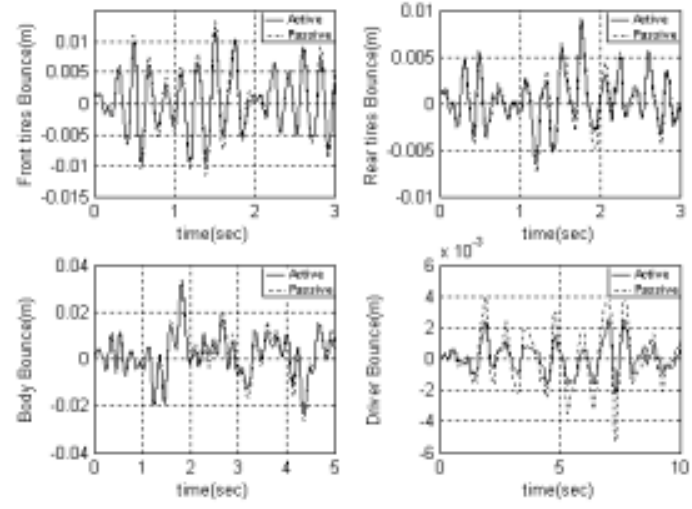
Fig. 6. Comparison between passive and active systems for the front and rear tires bounce, body bounce, and driver bounce.